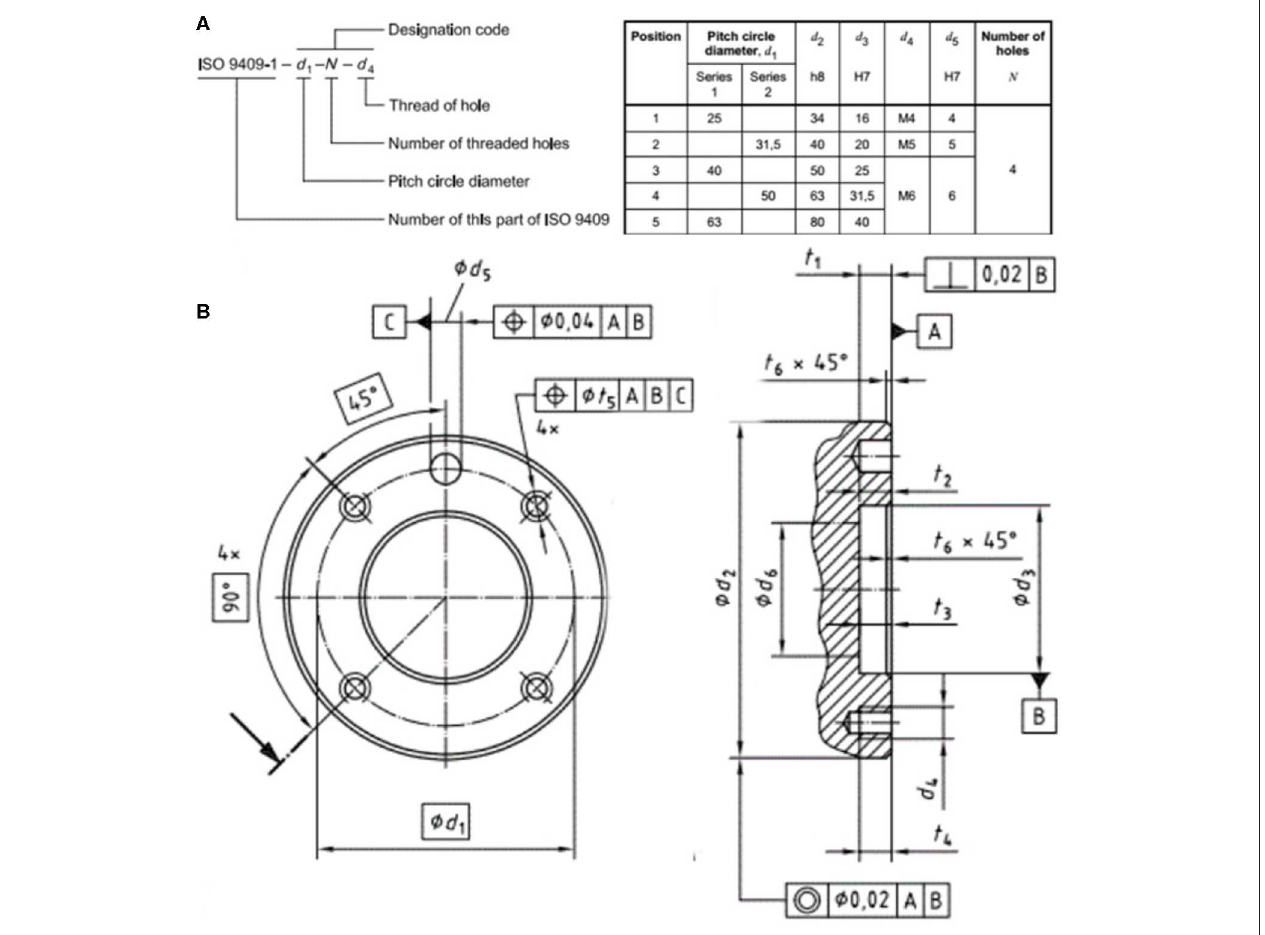
FIGURE 2 | Except from the ISO 9409-1: 2004 on the design standardization of robot flanges, including (A) the designation code format and recommended dimensions, and (B) the detailed mechanical drawings and notations.